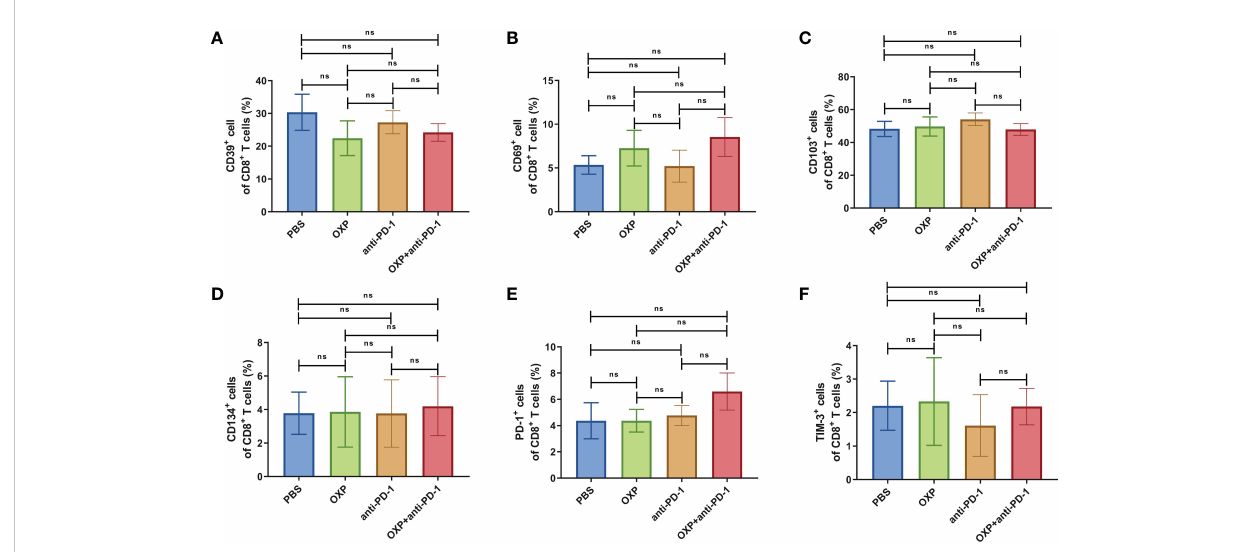
FIGURE 9 The phenotype of CD8 + T cells in PBMC. (A) The percentage of CD39 + cells of CD8 + T cells. (B) The percentage of CD69 + cells of CD8 + T cells. (C) The percentage of CD103 + cells of CD8 + T cells. (D) The percentage of CD134 + cells of CD8 + T cells. (E) The percentage of PD-1 + cells of CD8 + T cells. (F) The percentage of TIM-3 + cells of CD8 + T cells. ns P >